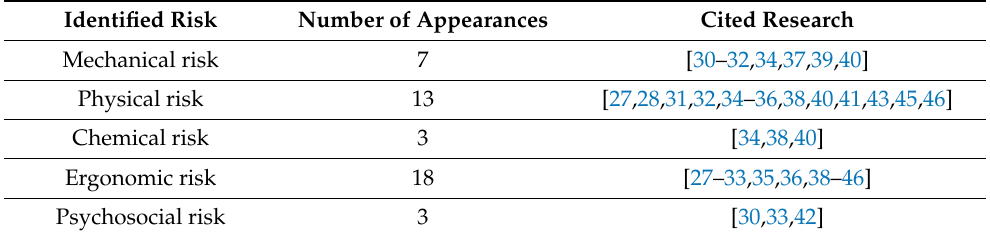
Table 3. Risk identification